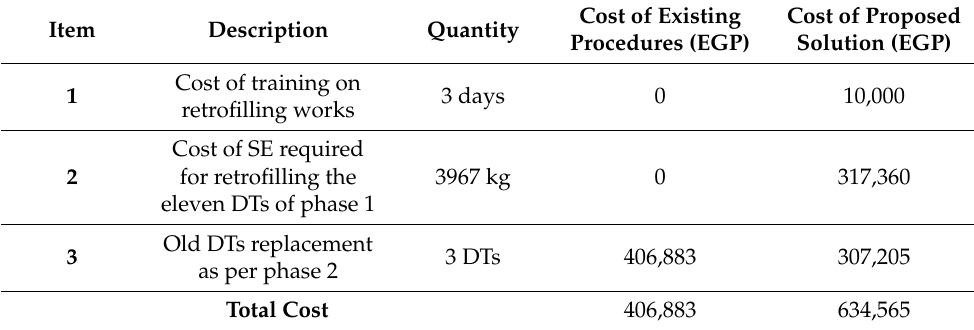
Table 3. Proposal cost compared to existing cost.